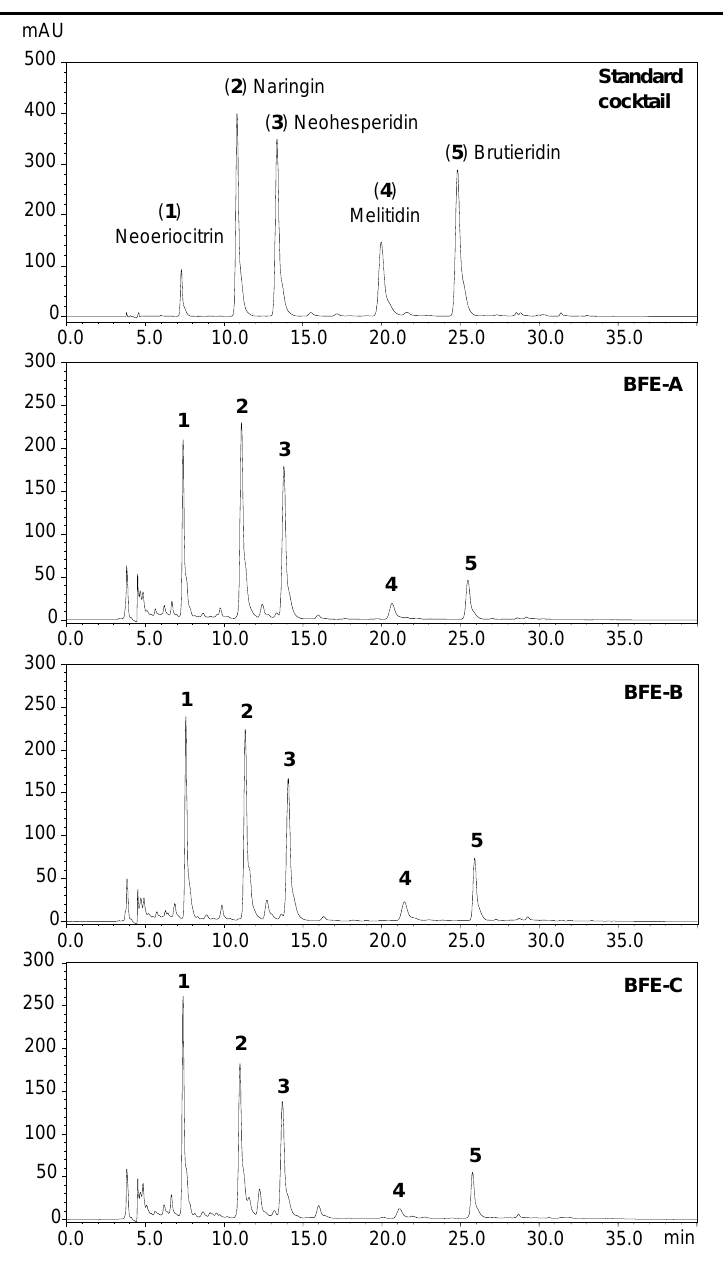
Figure 1. Representative HPLC chromatograms of standardized bergamot fruit extract (BFE). Table 1. Concentrations of flavonoid glycosides in bergamot extracts.